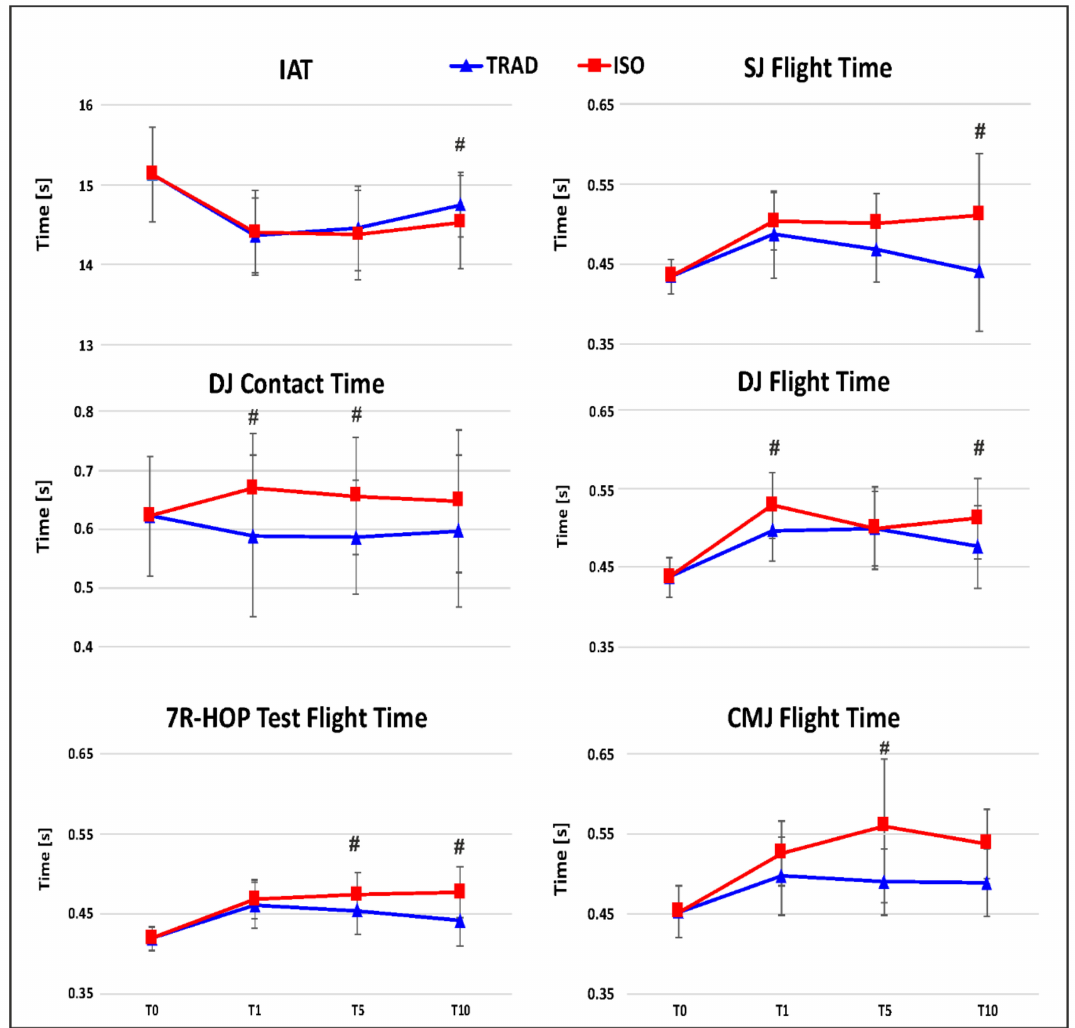
Figure 2. Time of Illinois Agility Test (IAT), flight time for the Squat Jump (SJ), Countermovement Jump (CMJ), and Seven Repetition Hopping Test (7R-HOP); flight time and contact time for the Drop Jump (DJ) test at the intervals considered in the present study (T0; T1; T5; T10). # denotes significant di ff erence between the two